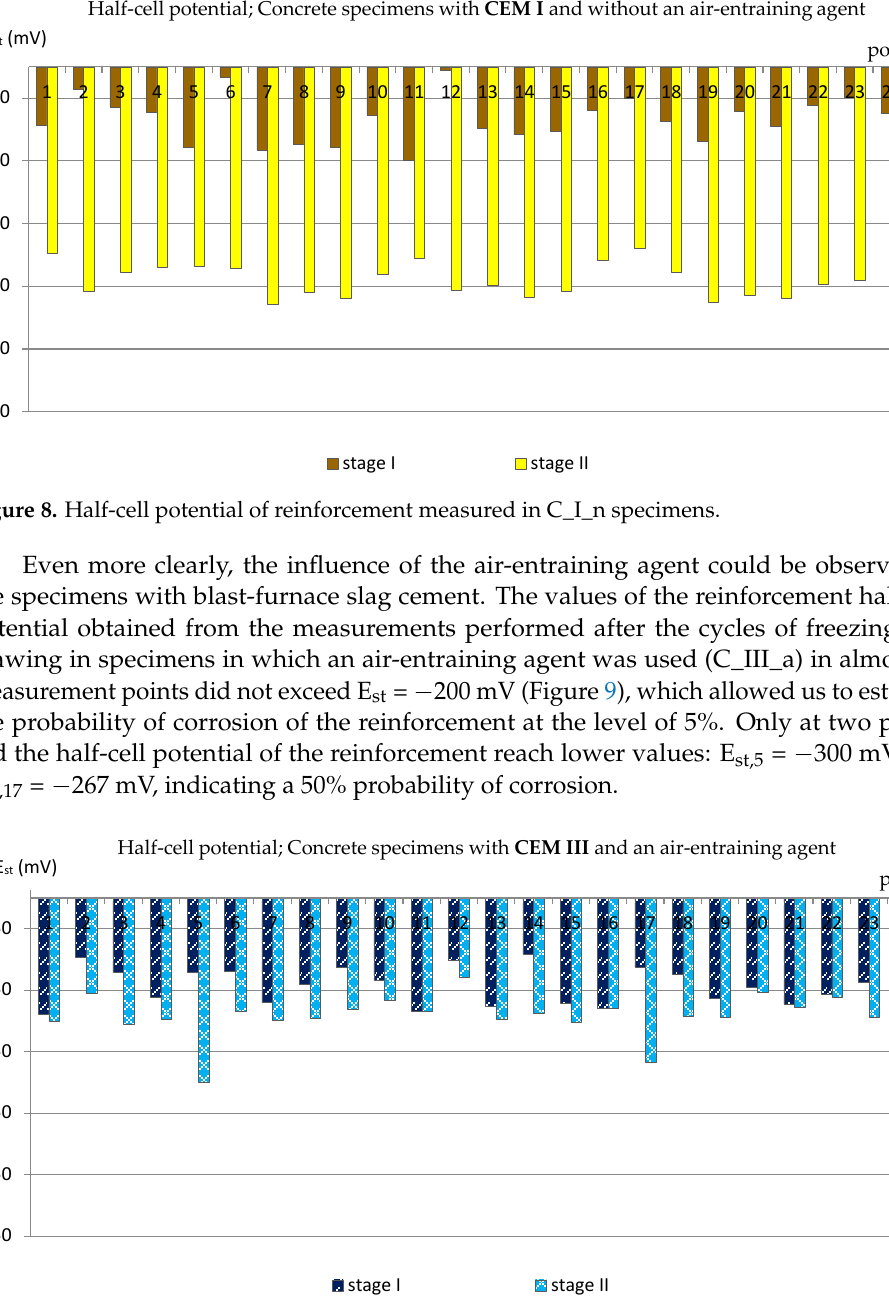
Figure 9. Half-cell potential of reinforcement measured in C_III_a specimens.